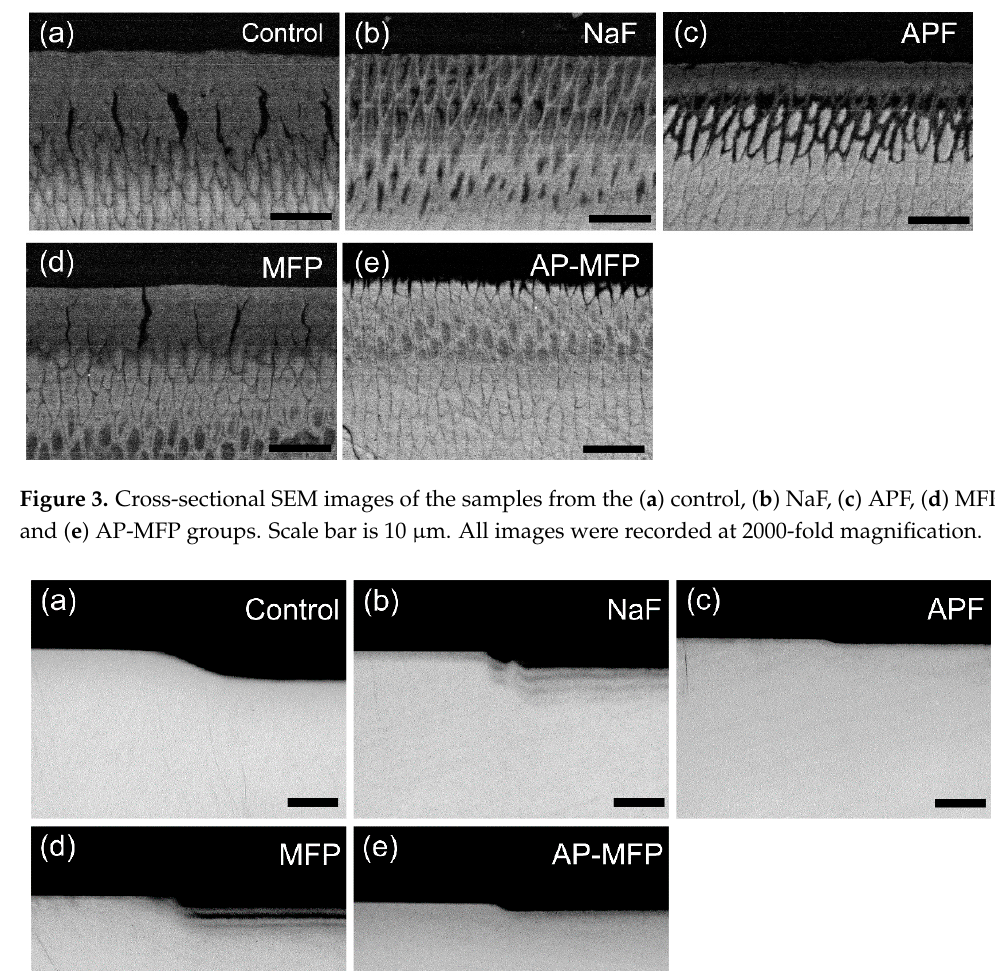
Figure 3. Cross-sectional SEM images of the samples from the ( a ) control, ( b ) NaF, ( c ) APF, ( d ) MFP, and ( e ) AP-MFP groups. Scale bar is 10 μ m. All images were recorded at 2000-fold magnification.